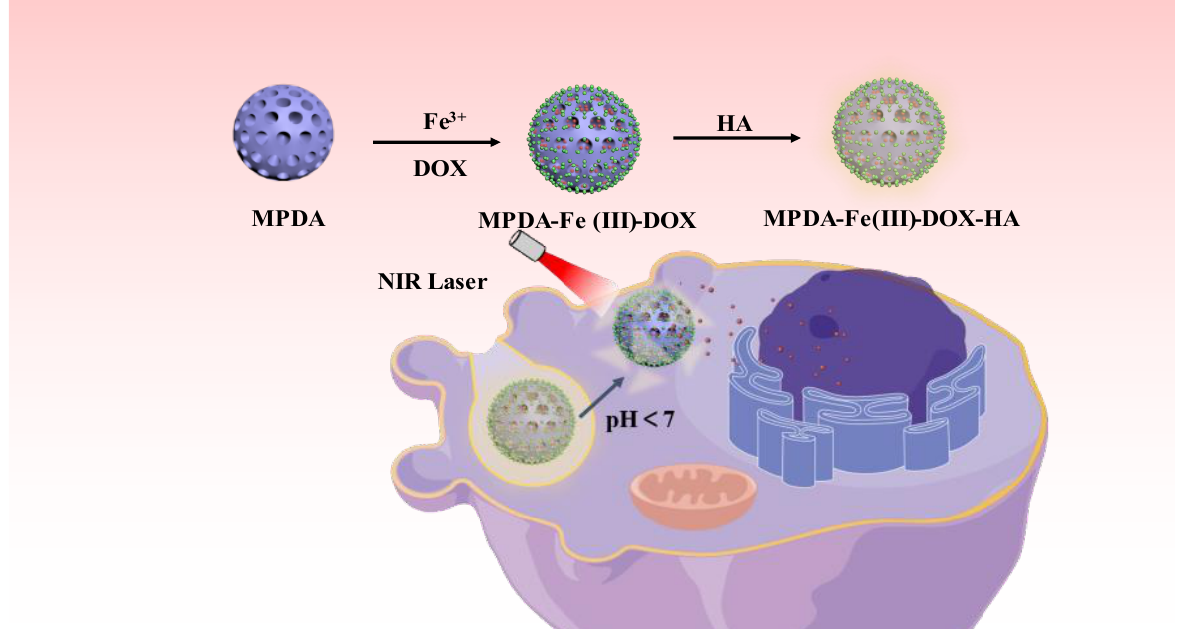
Figure 1. Schematic representation of the preparation of MPDA-Fe(III)-DOX-HA nanoparticles and their anti-tumor activity.